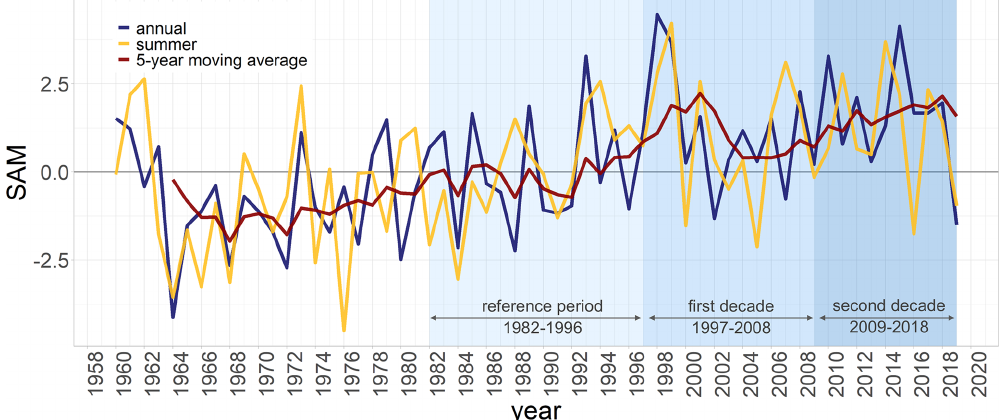
Figure 8. Southern Annular Mode (SAM) since 1960. Values are given for the annual SAM (blue), SAM during summer (orange), and a 5-year moving average for the annual SAM (red). The blue background indicates the investigated periods as delimited by the available coastline and climate data. For SAM during summer (December–February), the beginning of austral summer (hence December) indicates the year of the peak. Data: Marshall